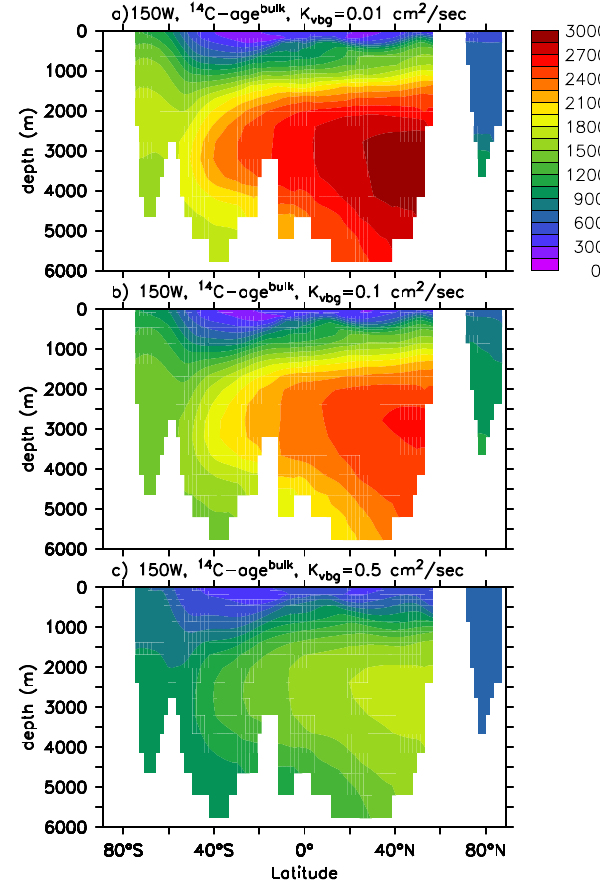
Figure 13. Vertical section along 150 ◦ W of bulk 14 C-age in the UVIC model for three different K vbg values. (a) K vbg = 0 . 01cm 2 s − 1 , (b) K vbg = 0 . 1cm 2 s − 1 and (c) K vbg = 0 . 5cm 2 s − 1